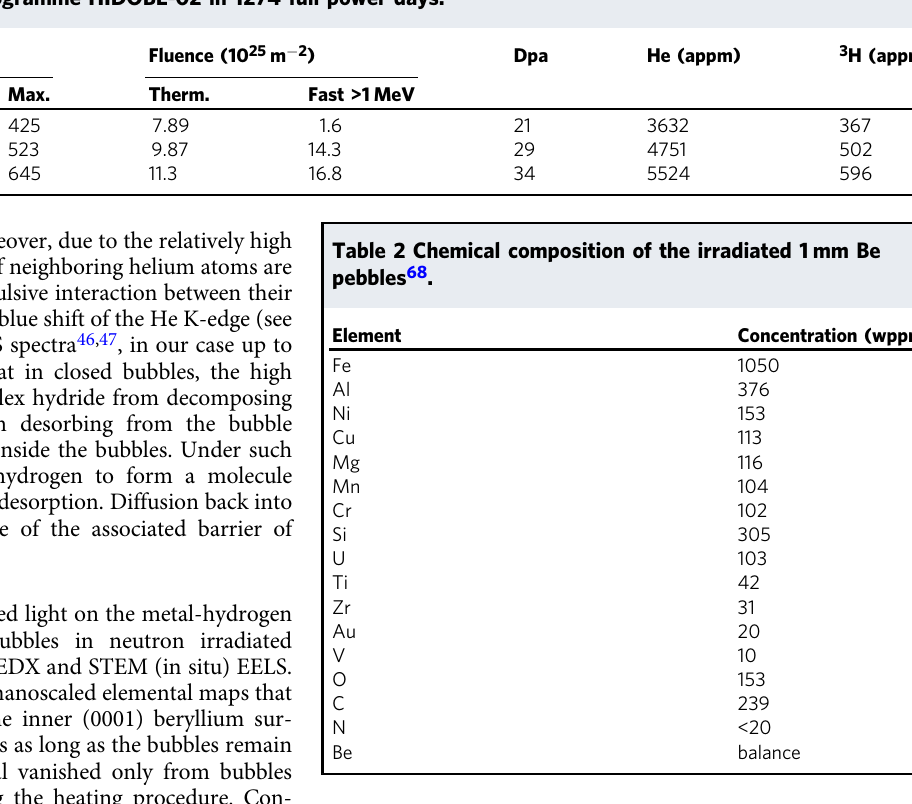
Table 1 Overview of the irradiation parameters for the constrained Be pebbles that were irradiated during the high dose beryllium neutron irradiation programme HIDOBE-02 in 1274 full power days.